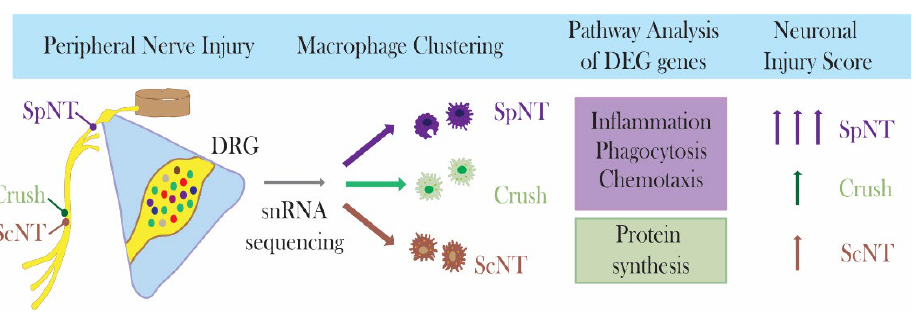
Figure 6. Sciatic and spinal nerve injuries show distinct effects on DRG macrophages.